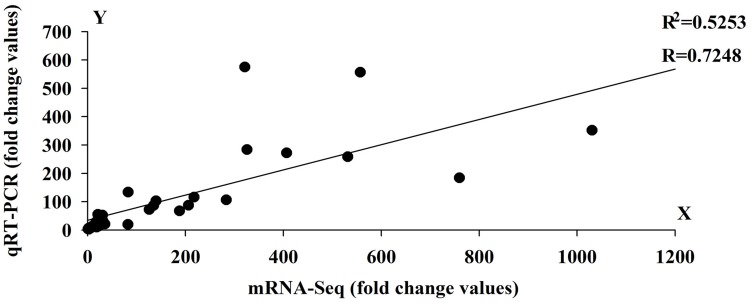
Linear regression analysis between Quantitative Real-Time PCR (qRT-PCR) and RNA-seq results (r = 0.7248) for 10 genes. X-axis numbers represent the fold change values of mRNA-seq results. Y-axis numbers represent the fold change values of qRT-PCR results.